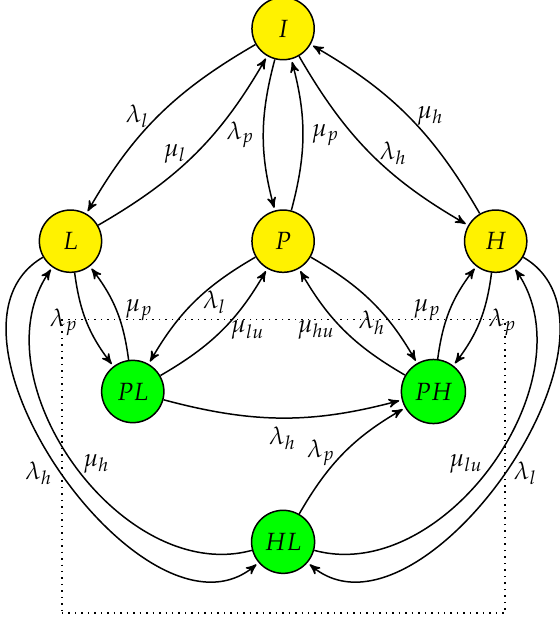
Figure 9. State transition diagram of